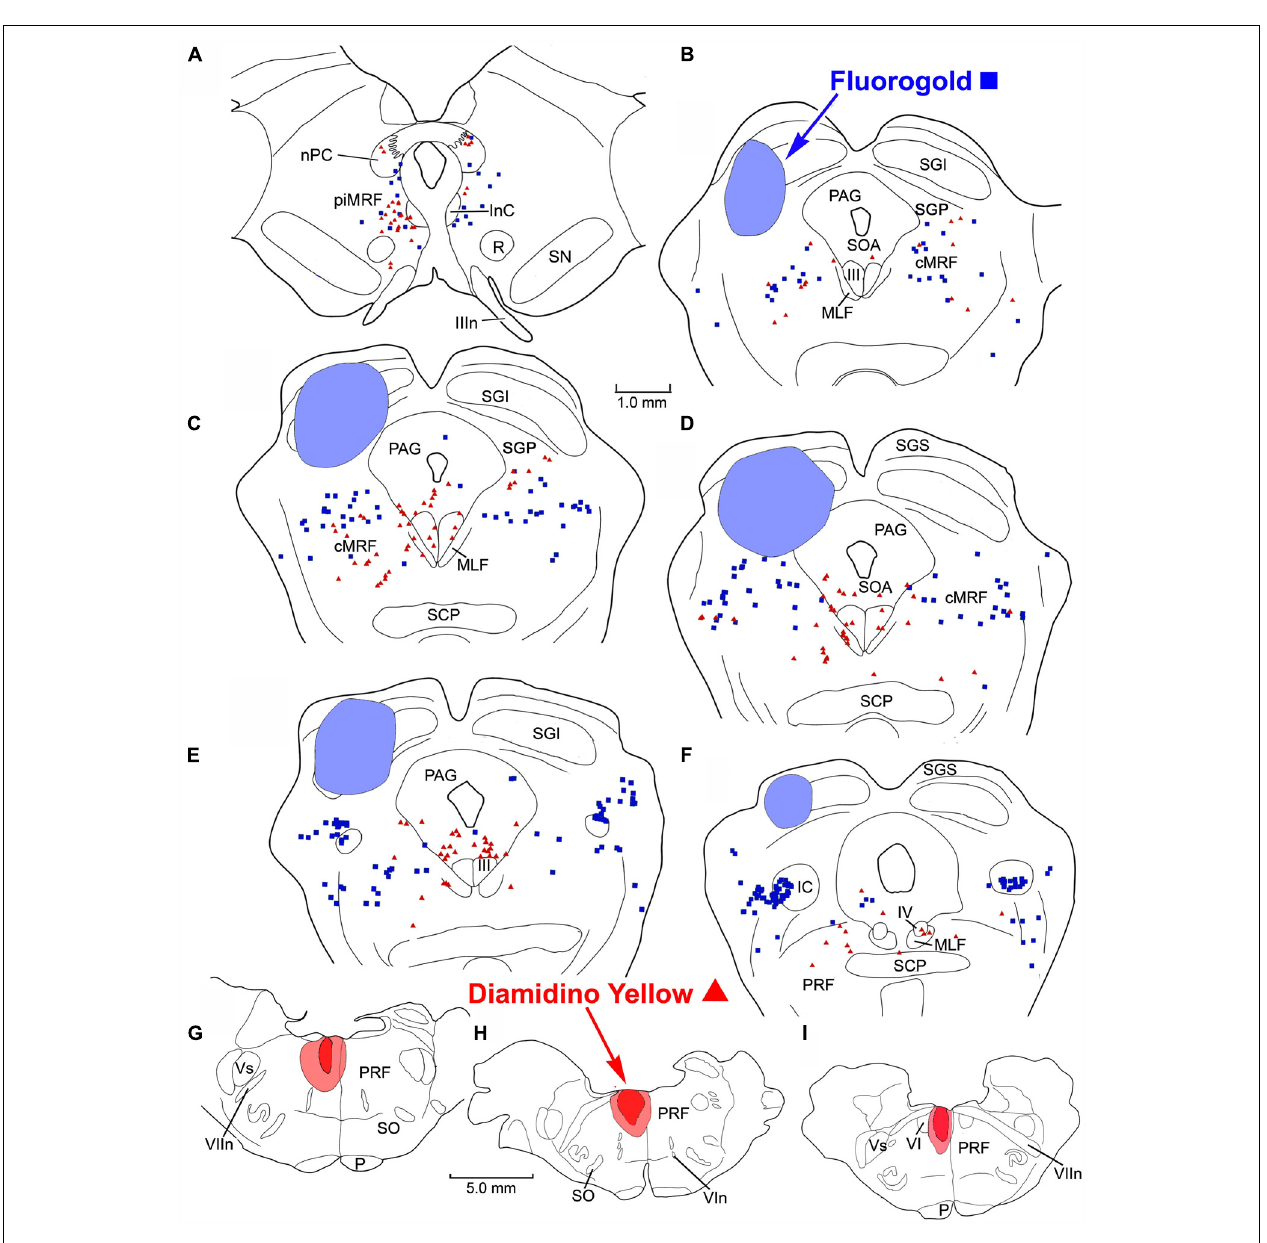
FIGURE 5 | Distribution of labeled reticulotectal neurons (cid:2) and pontine reticuloreticular neurons (cid:3) (A–F) from a fluorogold injection the SC (A–D) and a diamidino yellow injection into the medial PRF (G–I).